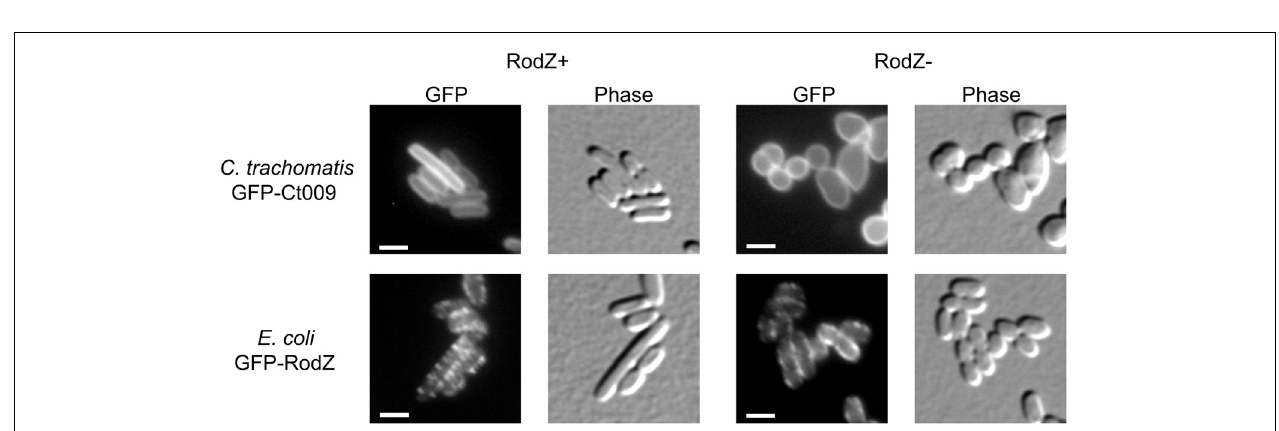
bottom panels and exhibits an ftsI- like expression pattern indicative of RB growth and division. DNase-treated total RNA was reverse transcribed and analyzed by qPCR. Data were normalized to genome numbers and are representative of two biological replicates analyzed in triplicate. Standard deviations were generally less than 5% of the average.